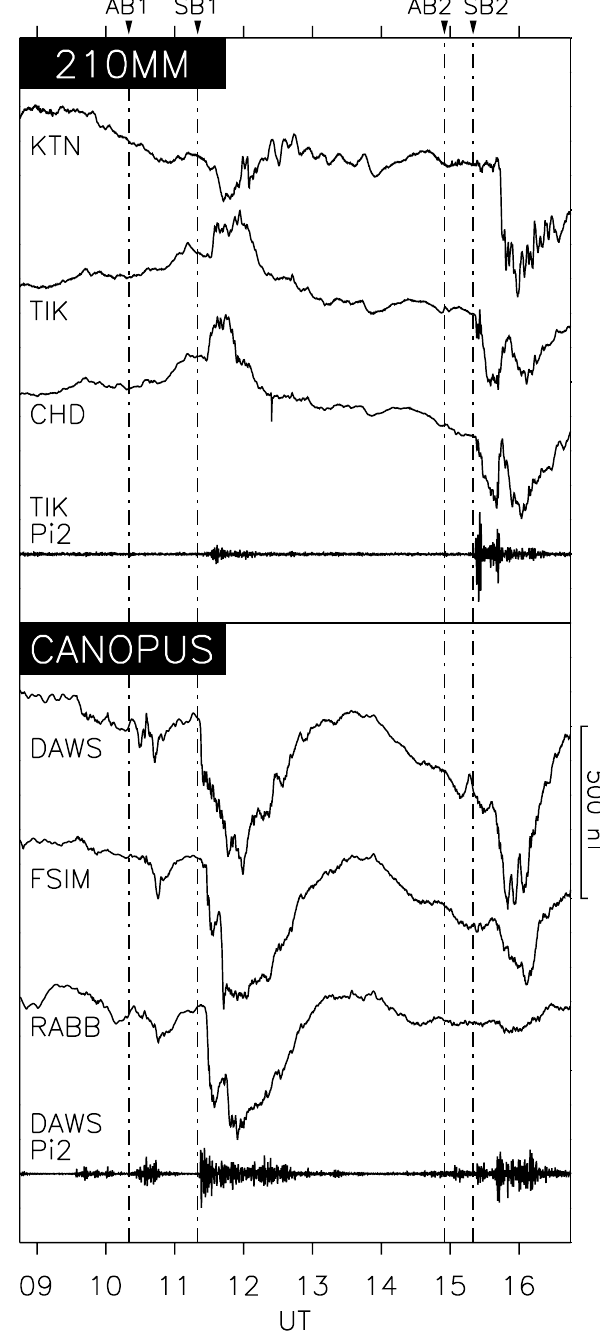
Fig. 3. H -component magnetograms from the 210MM and CANO- PUS networks, along with filtered data showing Pi2 activity (scaled by a factor of 5 for clarity). Vertical dot-dashed lines are the same as Fig.